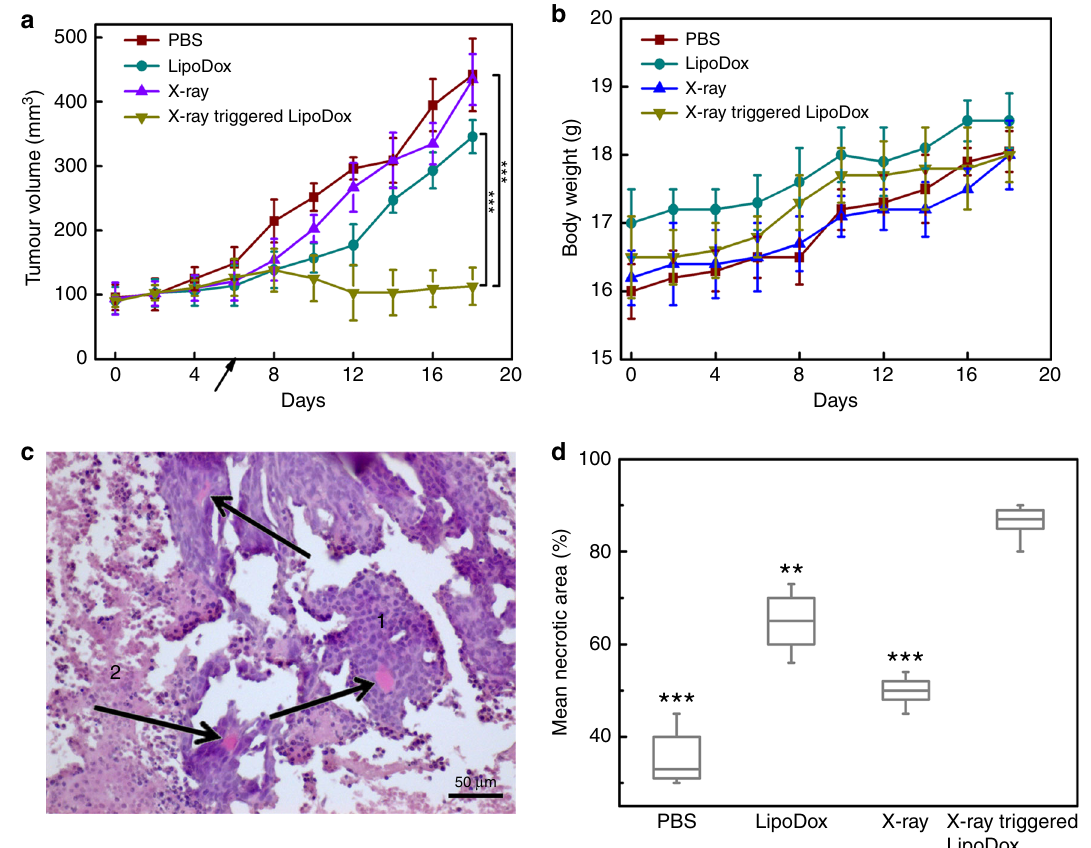
Fig. 6 Antitumour activity of X-ray triggered LipoDox in a xenograft model of colorectal cancer. a , b Changes of ( a ) tumours ’ volume and ( b ) mouse body weight after various treatments as indicated. A black arrow indicates the time of treatment administration. Error bars show standard deviation from four experiments. The mean tumour volumes were analysed using the t test ( n = 4). * P < 0.05, ** P < 0.01, *** P < 0.001. c The structural components of treated tumour (H&E staining). Viable tumour tissues (1) were composed of uniform cells with basophilic (blue) cytoplasm and large roundish hyperchromatic nuclei. The areas of cellular paranecrosis and necrosis (2) were recognised by disorganised groups of tumour cells with eosinophilic (pink) cytoplasm, with and without nuclei, respectively. Arrows indicate congested blood vessels. Note the spatial association between the viable tumour tissue and blood vessels. Scale bar is 50 µ m. d Boxplot shows morphometric analysis of the effect of the experimental treatment regimens on the structural composition of the xenograft tumours. The relative areas of the viable and non-viable (paranecrotic and necrotic) tumour tissues were measured using ImageJ open source software. The box is bounded by the fi rst and third quartile with a horizontal line at the median and whiskers extend to 1.5 times the interquartile range. The mean tumour necrosis percentage was analysed using the t test ( n = 5). * P < 0.05, ** P < 0.01, *** P < 0.001, compared with